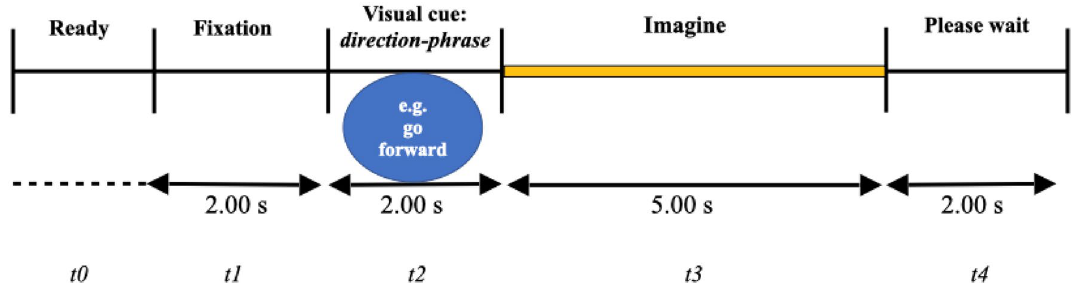
Figure 2. Timing presentation of the experimental paradigm of the whole body motor imagery. The start of each trial was signified by the presence of a short message “Ready”. This corresponds to t = 0. After, a fixation point appeared in the middle of the screen for 2 s, i.e., t = 1, fixation. After these 2 s, a direction-phrase indicating either "go forward" or "go backward" appeared for 2 s on the screen (i.e., t = 2). Once the words disappeared from the screen, each participant, facing the black screen, performed a motor imagery task, one at a time for 5 s, i.e., t = 3 . At the end of each motor imagery task, each participant was allowed to take a break "please wait", i.e. t = 4 for 2 s. In total, for 39 participants, there were 1,872 randomised trials. In 1,872 trials of 5 s each, resulted in 9360 s worth of data.